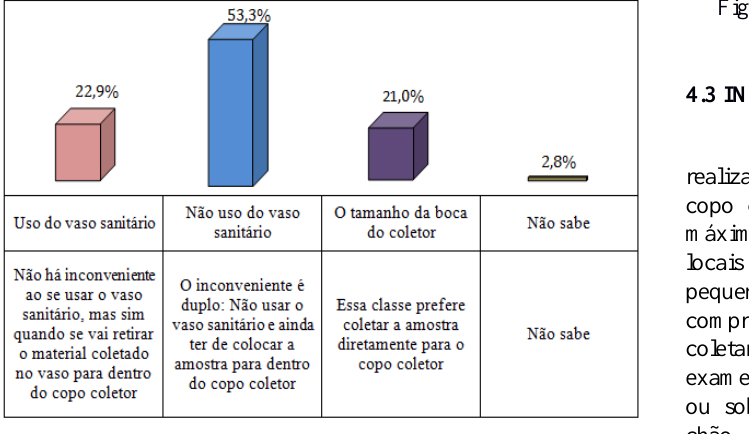
Figura 10. Percentual segundo o principal inconveniente quando se faz uma coleta de material de fazes.